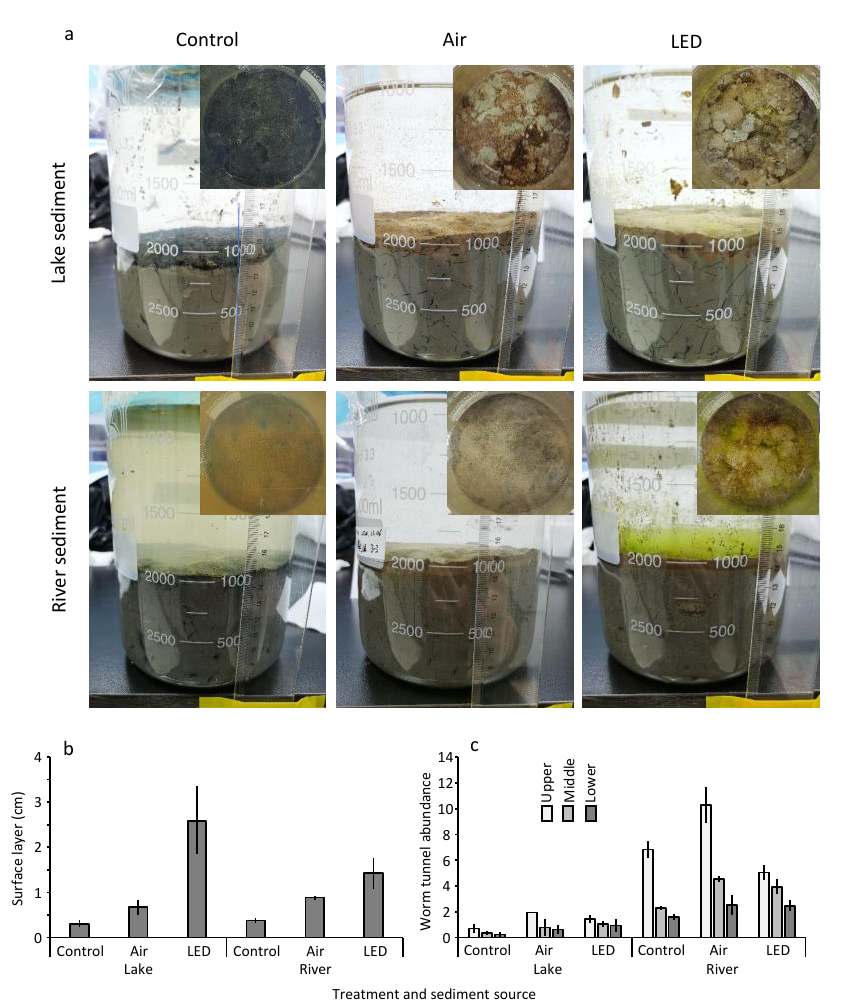
Figure 5. Lateral and top view of the microcosm (one of triplicate) with different treatments (control, aeration, LED) and sediment sources (lake, river) at the end of experiment ( a ), depth of the oxic layer ( b ), and abundance of invertebrate tunnels at different vertical positions of sediment (upper, middle, and lower) ( c ). Error bars show 1 SD.